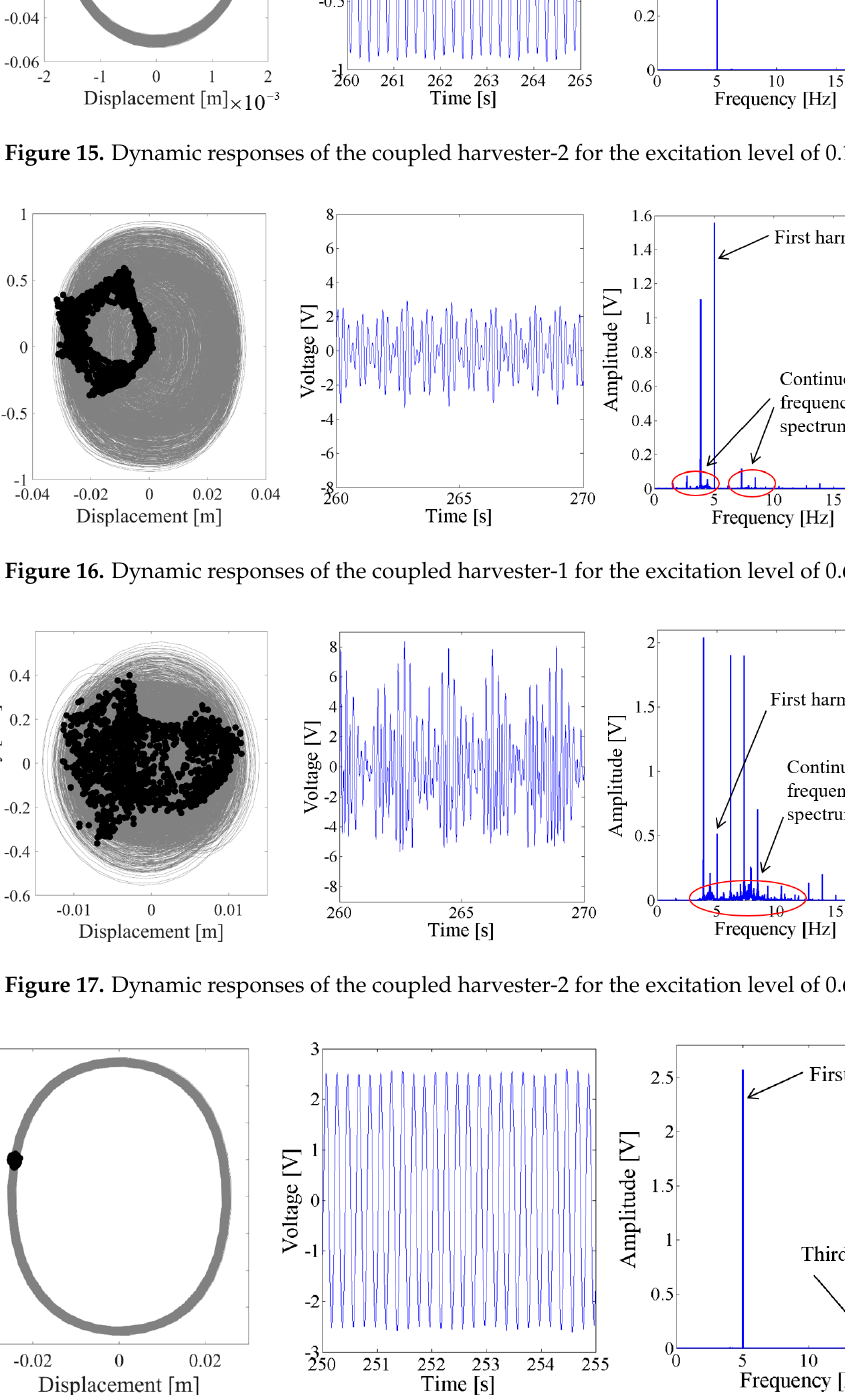
Figure 18. Dynamic responses of the coupled harvester-1 for the excitation level of 0.9 g.